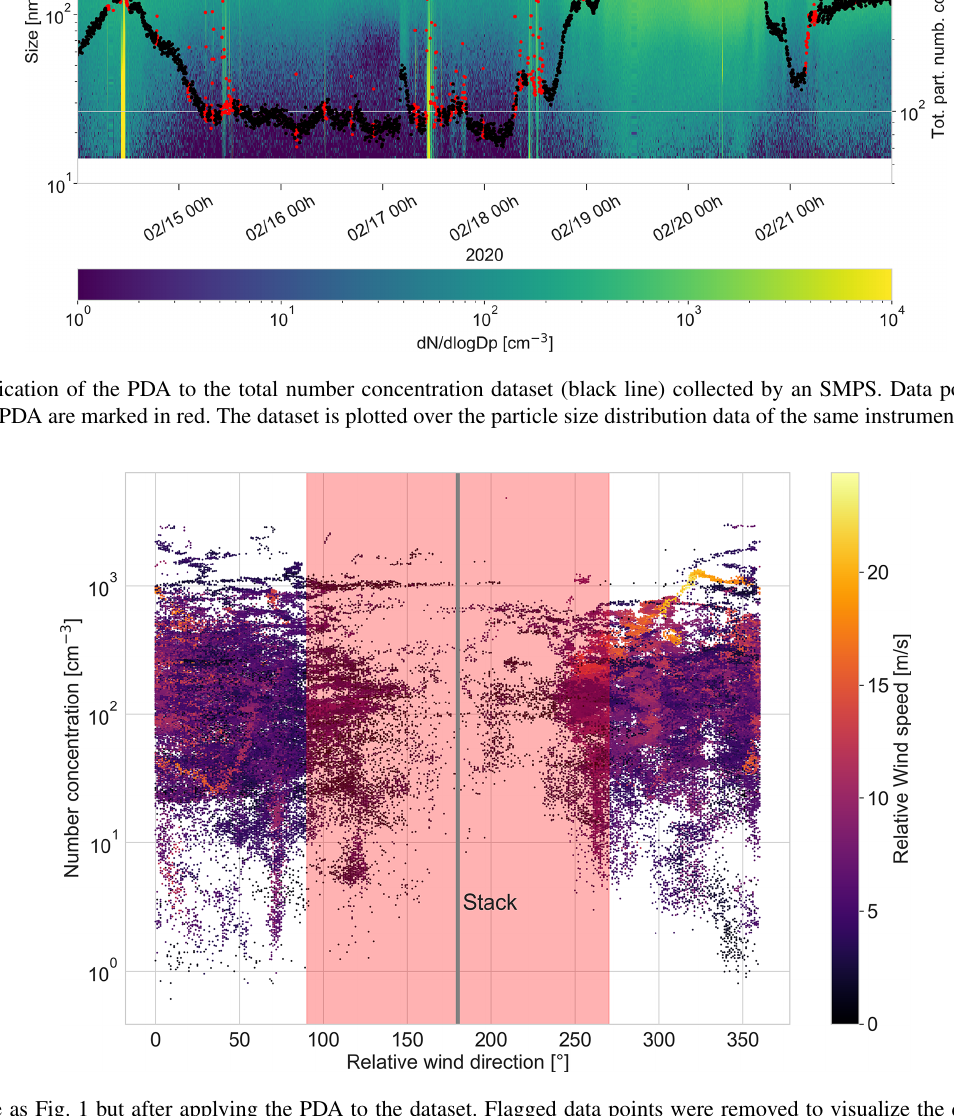
Figure 7. Same as Fig. 1 but after applying the PDA to the dataset. Flagged data points were removed to visualize the data product after application of all filtering steps. The red shaded area indicates where the wind filter would flag polluted data (between 90 and 270 ◦ relative to the bow). The direction of the stack is marked at 180 ◦ as a vertical